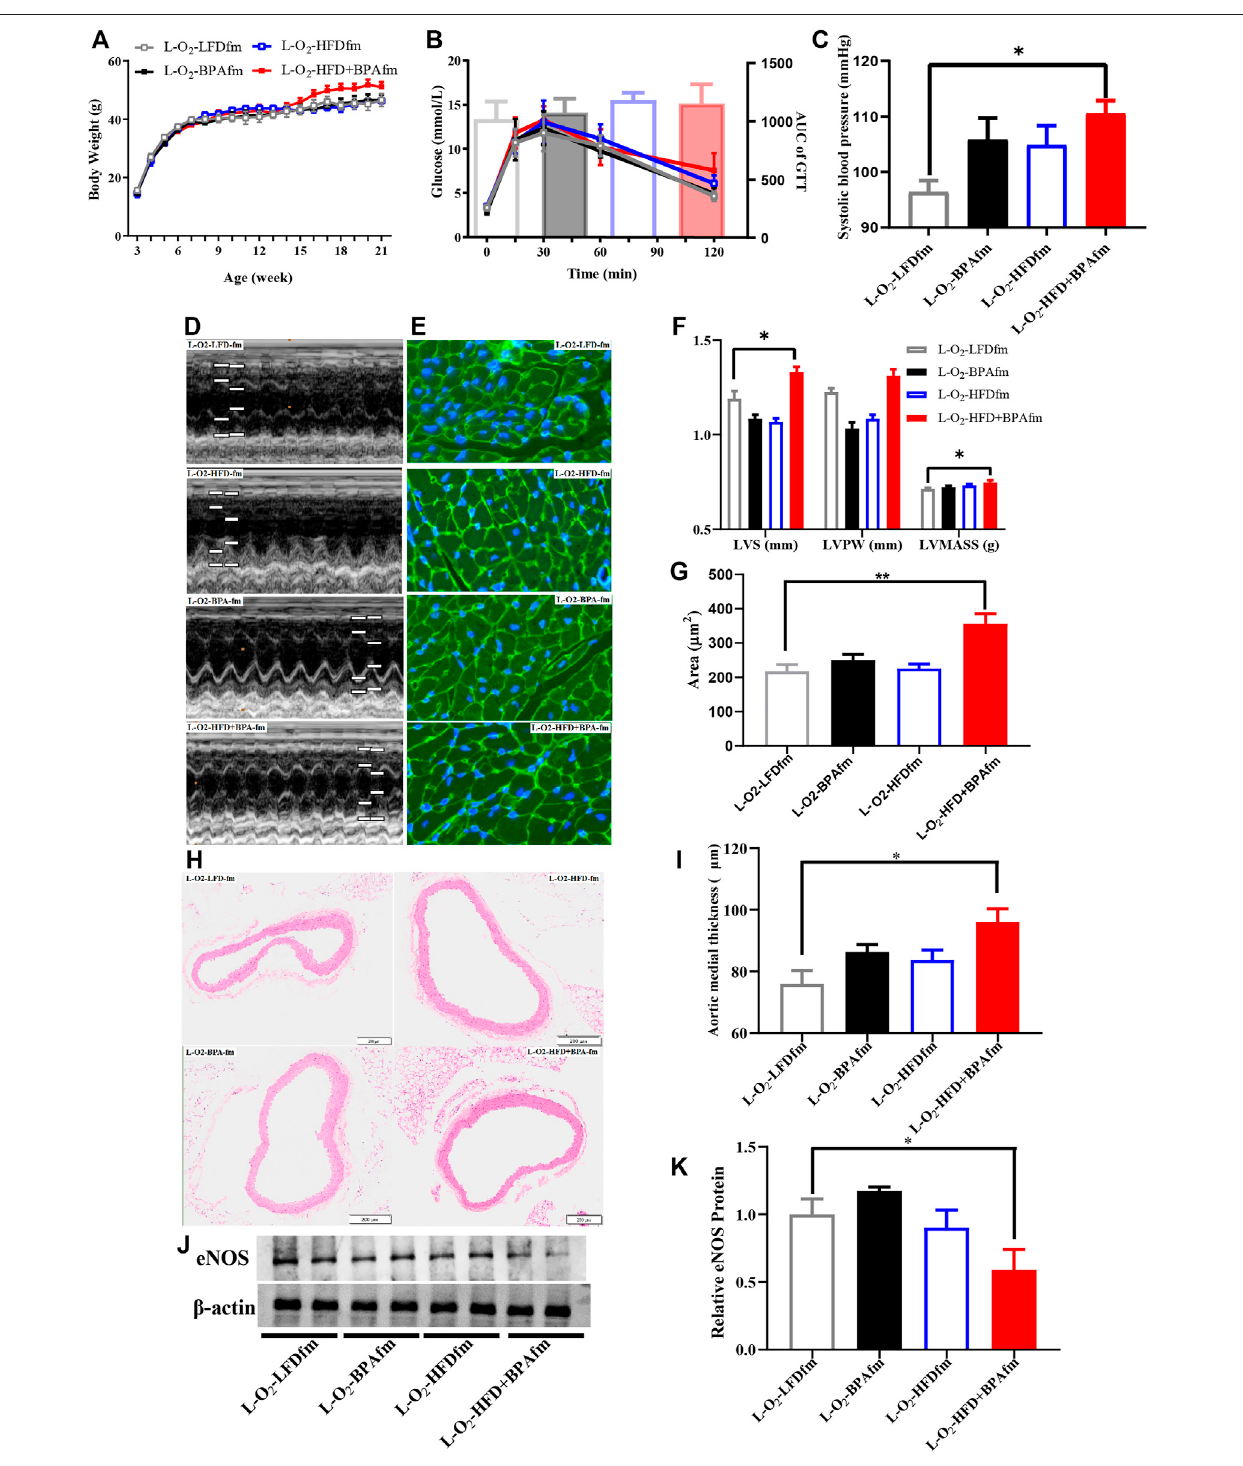
FIGURE 2 | HFD, BPA and their combination affect weight gain, metabolic pro fi le of matrilineal male F2. (A,B) The weight and glucose tolerance difference among the four groups of matrilineal male F2 from weaning to 21 weeks. (C) The SBP among the four groups of matrilineal male F2. (D,F) Echocardiograms among the four groups of matrilineal male F2. (E,G) Representative photomicrographs depicting WGA staining of cardiomyocytes and average cardiomyocyte area of matrilineal male F2. (H,I) Representative photomicrographs depicting hematoxylin eosin staining of aorta and arterial media thickness. (J,K) Western blotting results and quantitative analysis for aortaof matrilineal male F2. Data aremean ± SEM and were analyzed bytwo-way ANOVA witha posthoc test. * p < 0.05, ** p < 0.01, BPA, HFD, BPA + HFD vs. LFD.